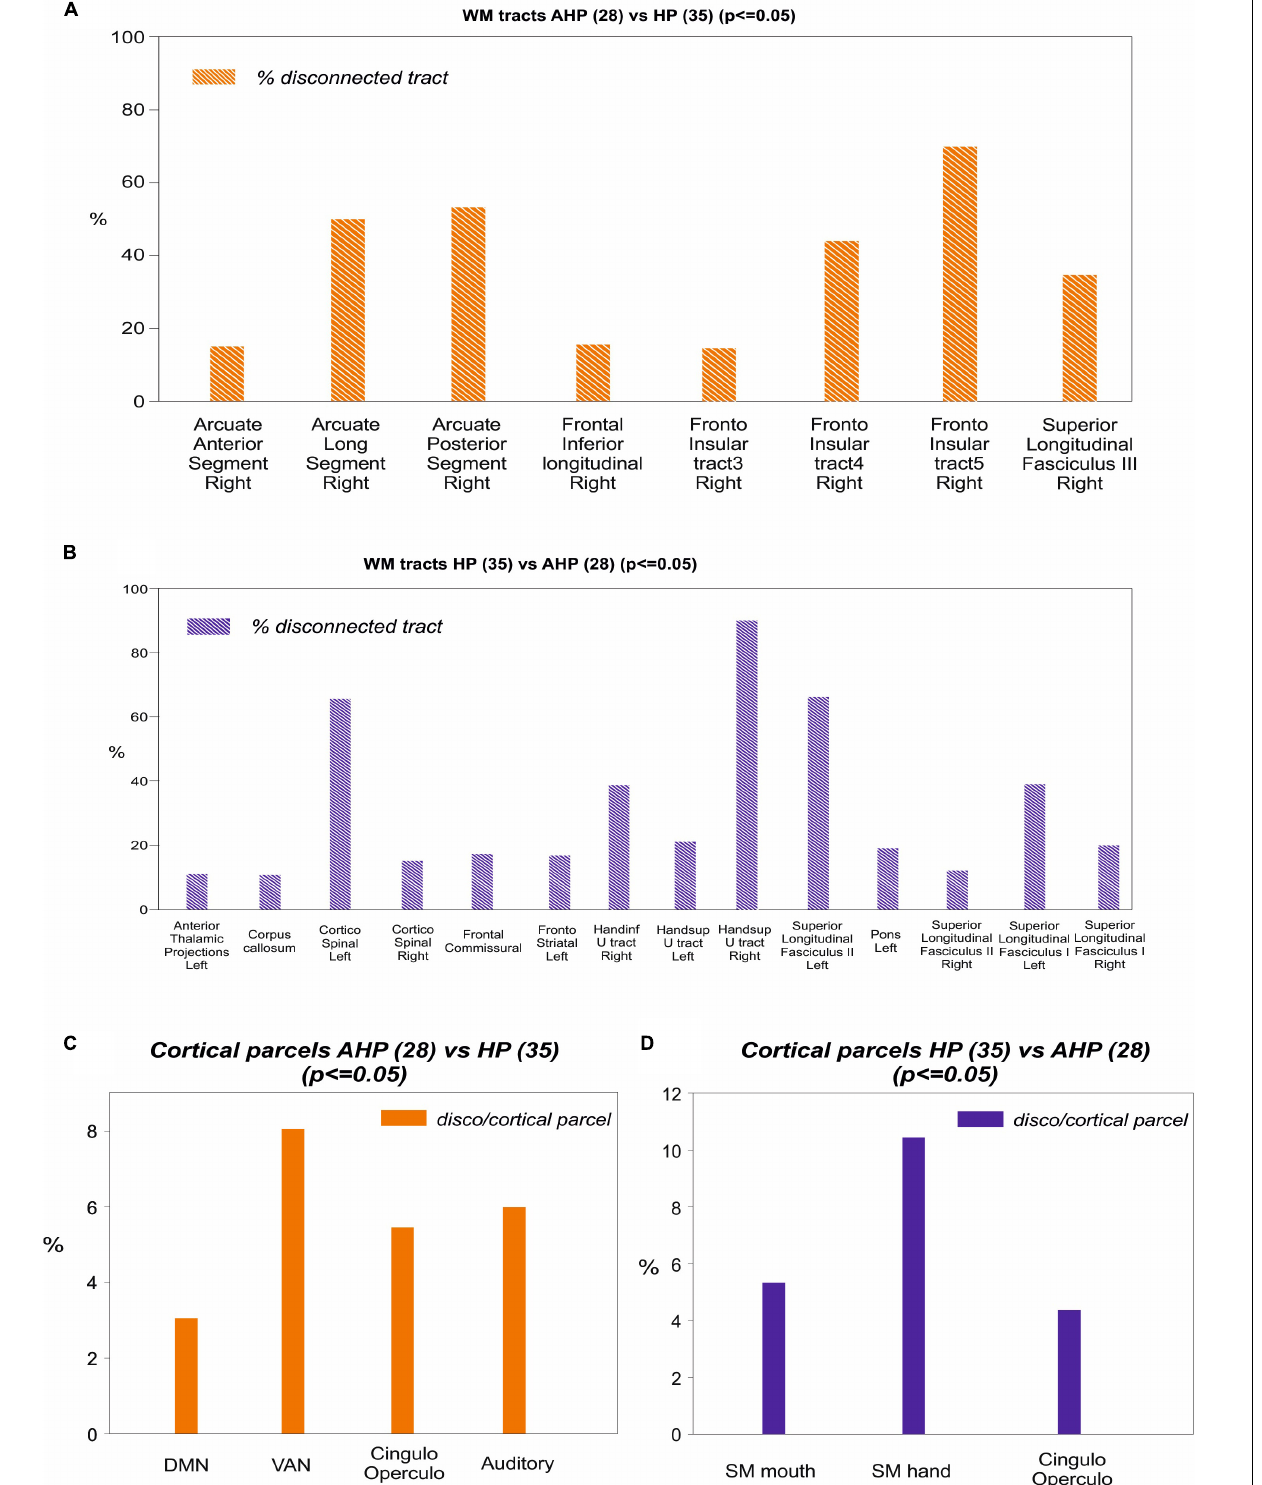
Frontiers in Systems Neuroscience |